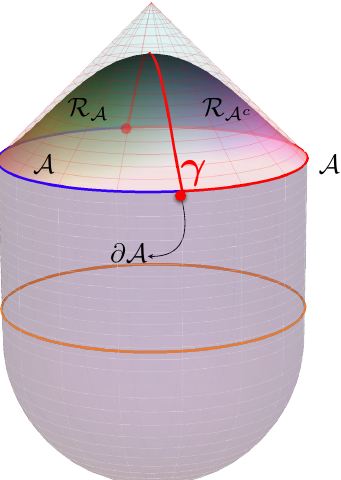
Figure 4. The bulk domains of interest in the Lorentzian construction for either the ket or the bra spacetime. Given a partition of Σ ˜Σ = Σ admits a decomposition ˜Σ ∂ t t codimension-2 surface g , which is anchored on the entangling surface. On saddle point solutions this surface approaches the extremal surface as n → 1